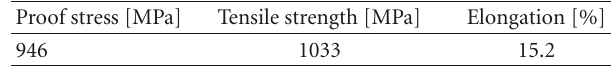
Table 1: Mechanical properties of Ti-6Al-4V